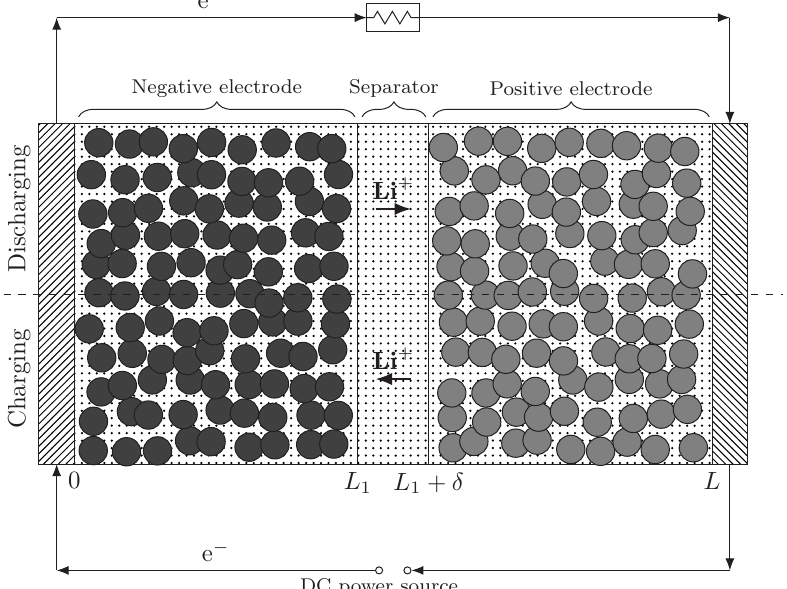
Figure 1: Schematic representation of a battery. Dark gray disks represent negative electrode particles, light gray disks represent positive electrode particles, the dotted region represents the presence of electrolyte. On both sides of the cell the lined region represents the current